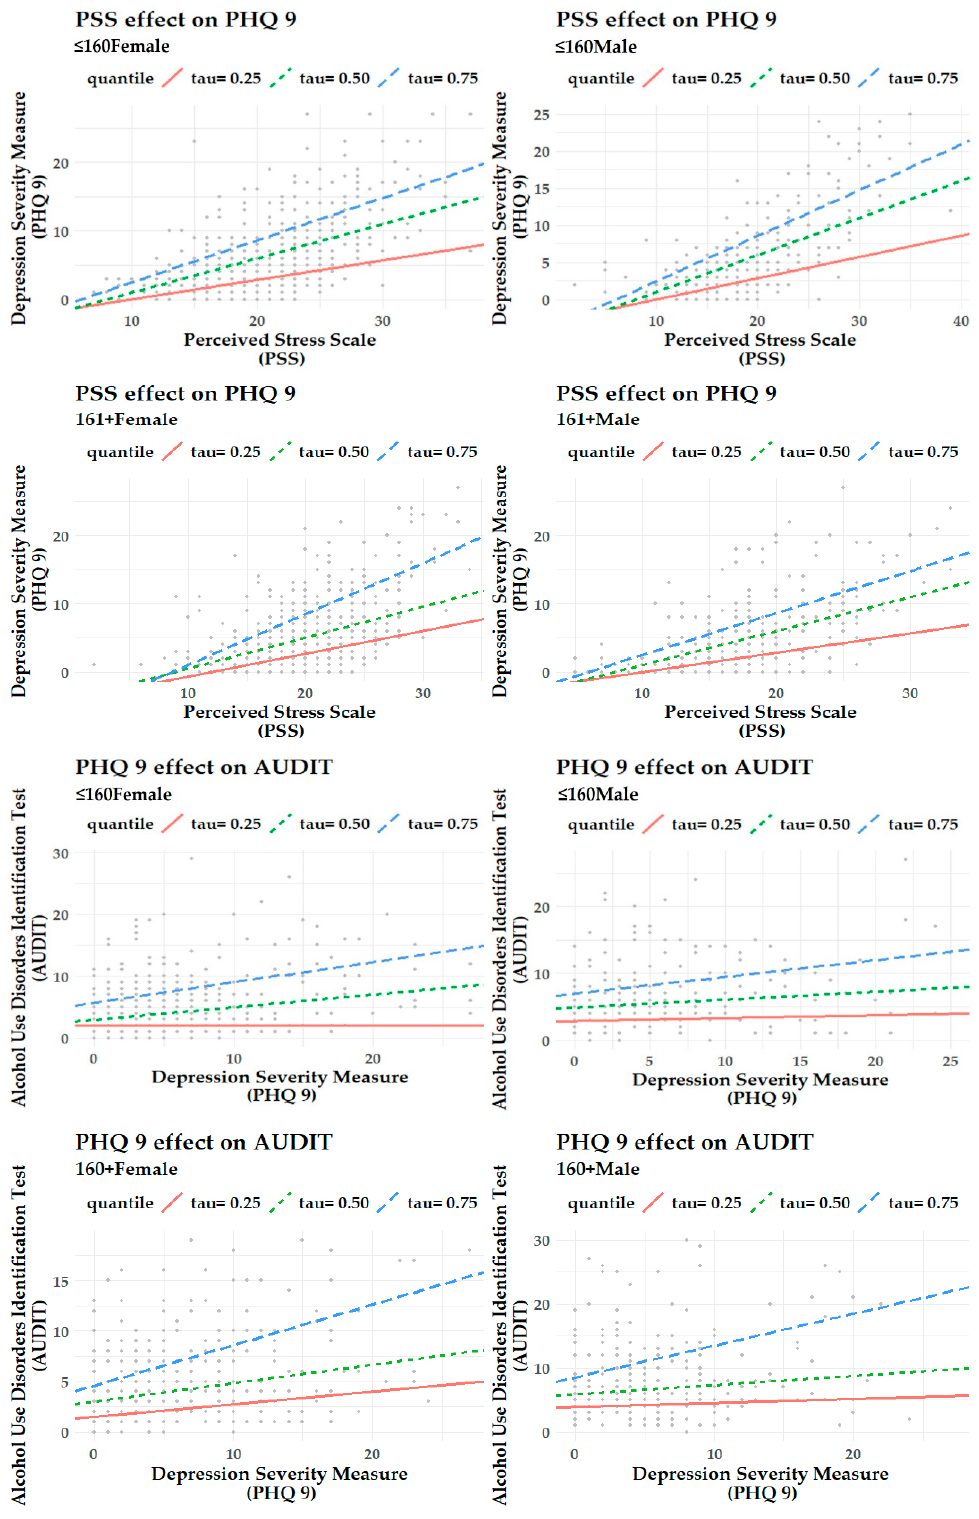
Figure 3. Visualization of effects. Figure A1. Visualization of e ff